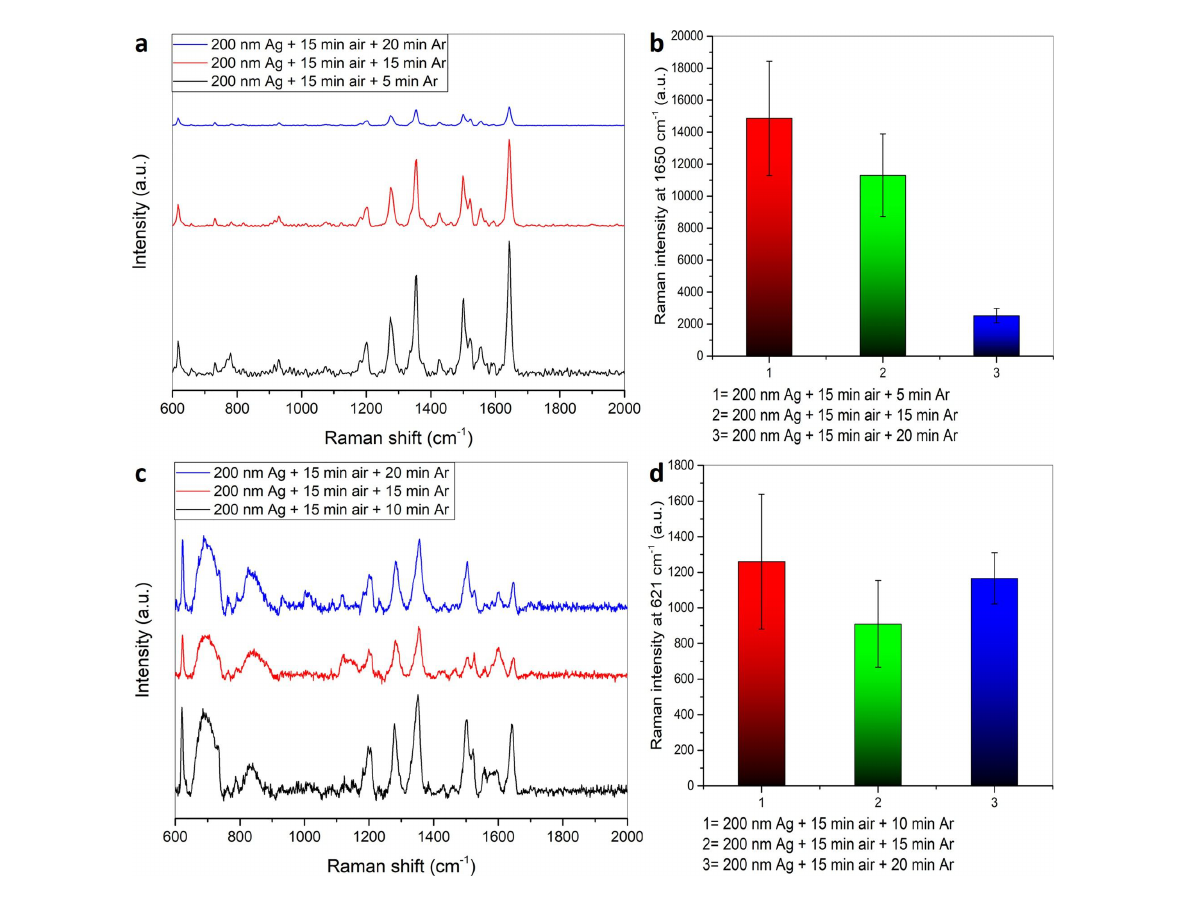
Figure 16: Comparison of the SERS spectra of 10 -6 M RhB on different SERS substrates prepared through oxidation of 200 nm silver film with air plasma (g12-p200) for 15 min followed by reduction with an argon plasma (g16.7-p200) for different times using (a) 532 nm and (c) 632.8 nm laser. Comparison of the average Raman intensities at (b) 1650 cm -1 (532 nm laser excitation) and (d) 621 cm -1 (632.8 nm laser excitation) on the corre- sponding